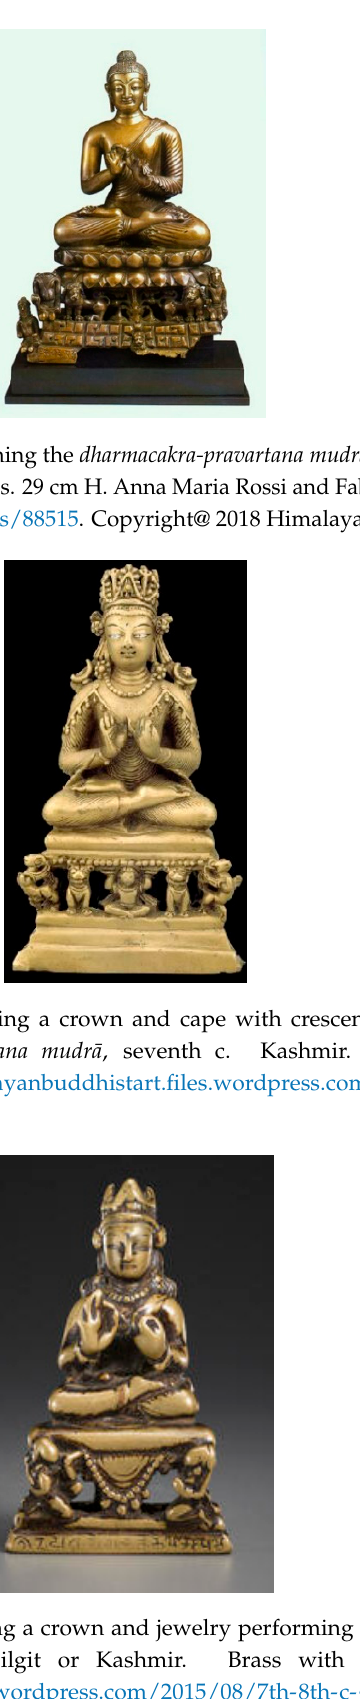
Figure 35. Vairocana Buddha performing the dharmacakra-pravartana mudr ā . Approx. 675–722 C.E. Kashmir or Gilgit. Brass with copper and silver inlay. 30.3 cm H. Po ta la Collection: Li ma lha khang: inventory no. 1383. Red Palace, Lhasa, Tibet. https://himalayanbuddhistart.wordpress.com/category/ all/gilgit/#jp-carousel-178.